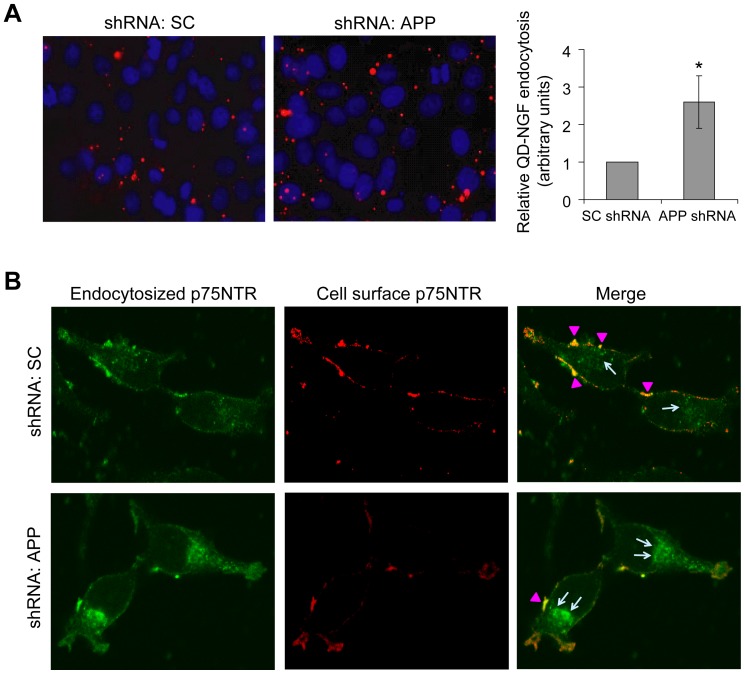
APP deficiency promotes endocytosis of NGF and NGF receptors.(A) PC12 cells stably expressing APP shRNA and control cells expressing scrambled control (SC) shRNA were treated with 1 nM QD-NGF for 3 h. After a complete wash, cells were fixed, permeabilized, stained with DAPI, and observed under a fluorescent microscope. Residual QD-NGF (in red) levels were quantified from 5 randomly selected regions with comparable cell numbers. Control was set as one arbitrary unit. *: P<0.05. (B) Cells were first incubated with a p75NTR antibody at 4°C for 1 h, and then treated with 100 ng/mL NGF at 37°C for 1 h. Cells were fixed and incubated with a secondary antibody conjugated with Alexa Fluor®-594 for 1 h. After a complete wash, cells were permeabilized and then incubated with another secondary antibody conjugated with Alexa Fluor-488. Cells were observed under a confocal microscrope. Arrows and arrow heads indicate internalized and cell surface p75NTR, respectively.